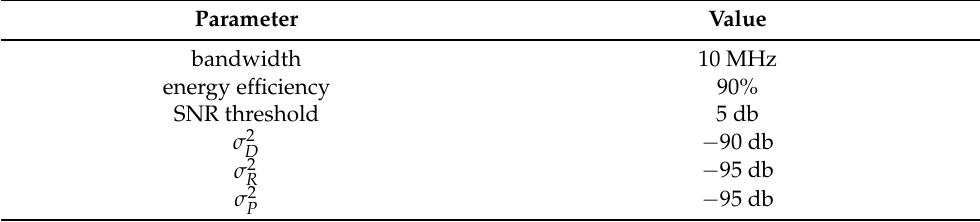
Table 1. Parameters used in simulation.